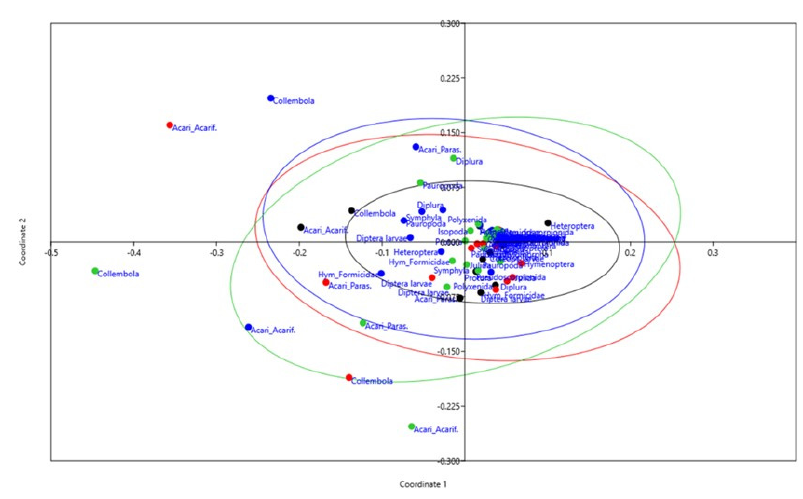
Figure A1. Euclidean-based nonmetric multidimensional scaling (NMDS) plot on the ecomorphotypes composition of the soil plots (stress value by Shepard plot: 0.16). Ellipsoids represent a 95% confidence interval for each treatment (NC-UC: green; NC-IR: blue; CT-UC: red; CT-IR: